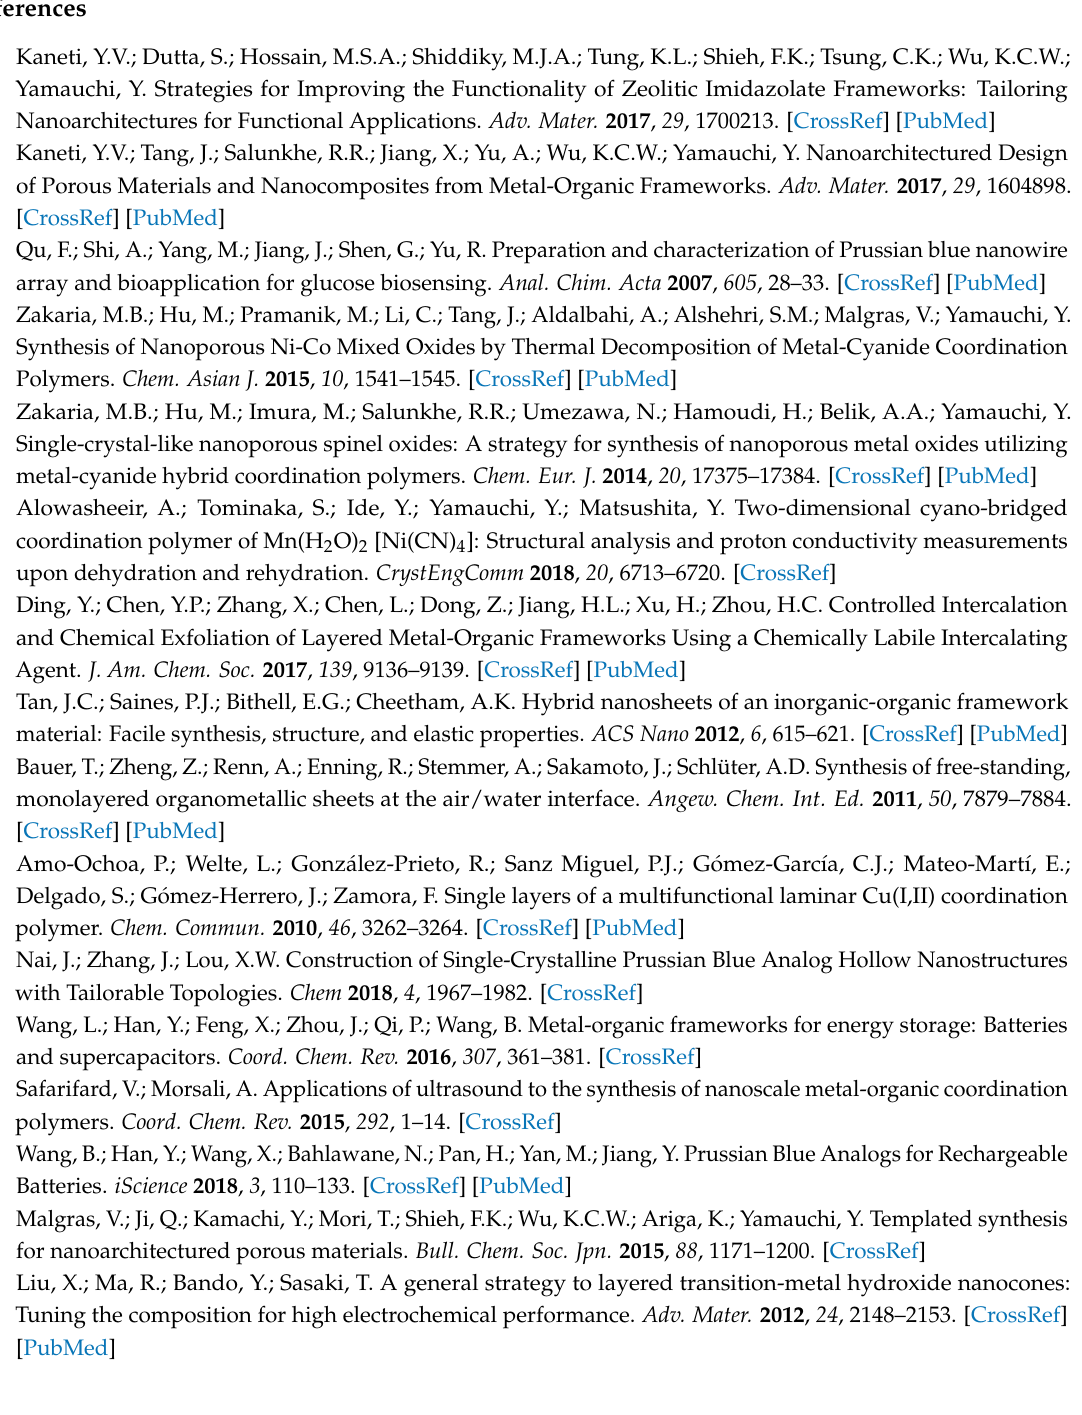
Figure S1: UV-vis spectra of Cu(NO 3 ) 2 solution with and without TSCD, Figure S2: TEM image of Cu-Ni_0.2, Figure S3: TG-DTA data of Cu–Ni_0.2. The measurement was carried out in air, Figure S4: TEM image of Cu-Ni_0.2_300. Figure S5: High-resolution XPS spectra for (a) Cu 2p, (b) Ni 2p and (c) O 1s of